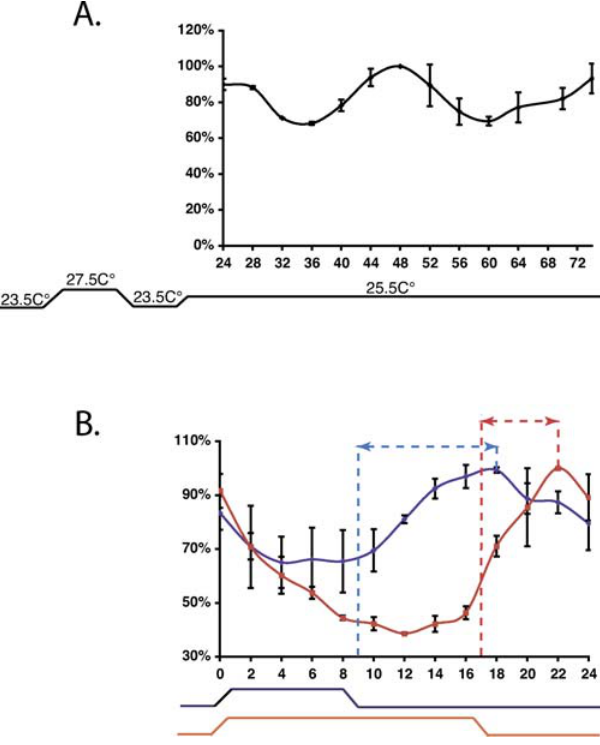
Figure 2. Temperature Cycles Entrain the Zebrafish Circadian Clock (A) Quantification of per4 expression levels as measured by RPA, in WT PAC-2 cells initially exposed for 6 d to a 4 8 C temperature cycle and then transferred to a constant temperature (25.5 8 C) for 72 h. RNA extracts were prepared from 24 h to 72 h following transfer to the constant temperature at four hourly intervals. RPA band intensities were quantified and adjusted as described in Figure 1. (B) RPA results quantifying per4 expression levels in WT PAC-2 cells exposed for 5 d to warm:cold temperature cycles (as indicated below the x -axis), including either a 8 h:16 h (blue trace), or a 16 h:8 h (red trace) cycle. The blue and red dashed lines and arrowheads indicate the delay between the warm–cold transition and the peak of per4 rhythmic expression in each temperature cycle. All experiments were performed in triplicate, and error bars denote the standard deviation. DOI: 10.1371/journal.pbio.0030351.g002